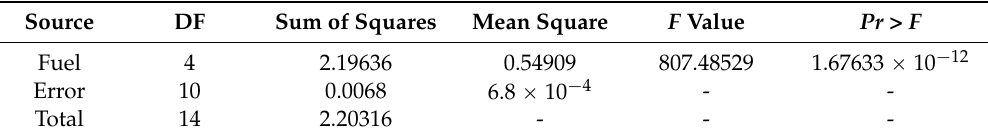
Table 3. Tukey grouping results for the fuel properties.